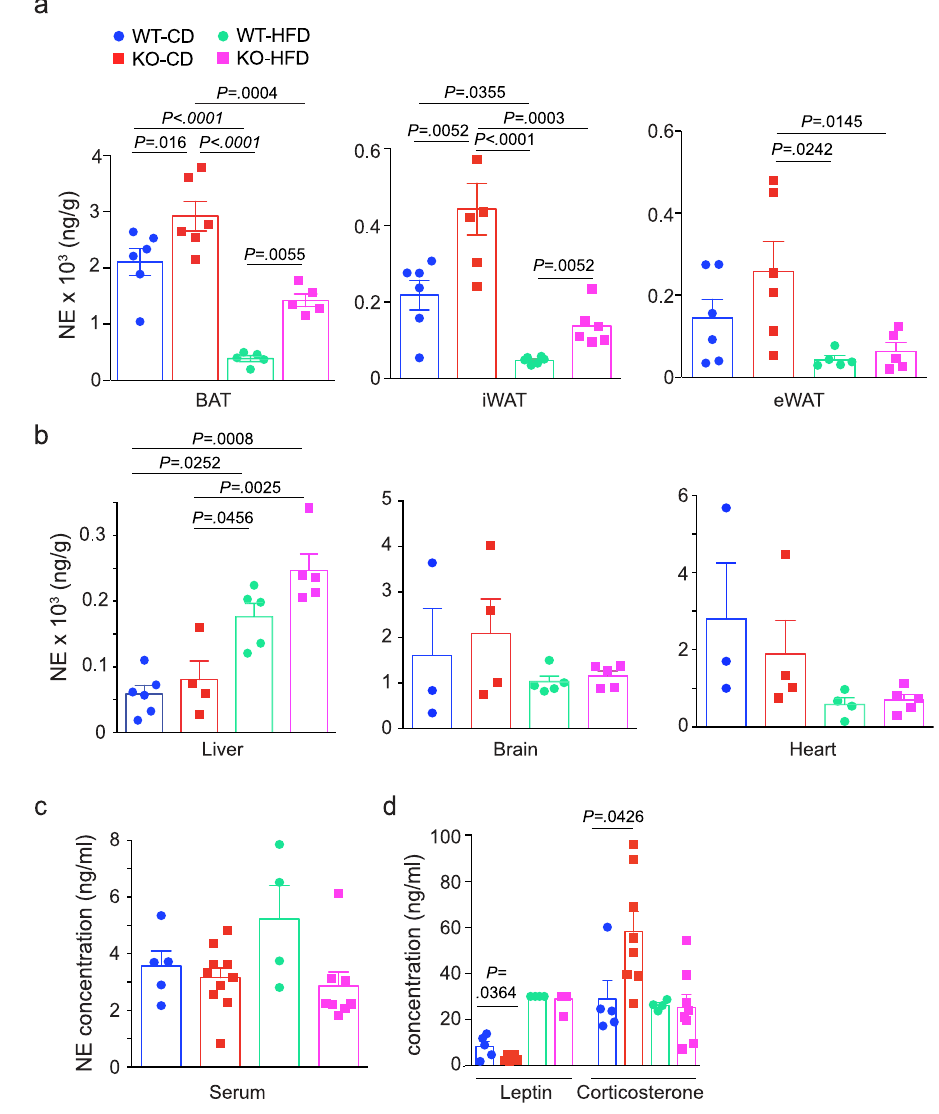
Fig. 3 | The increase in NE levels with AIF1 de fi ciency is restricted to adipose tissues. WT and AIF1-de fi cient (KO) mice were fed with CD or HFD. After 16 weeks of diet, NE levels were measured by LC/MS. a – c NE levels in adipose